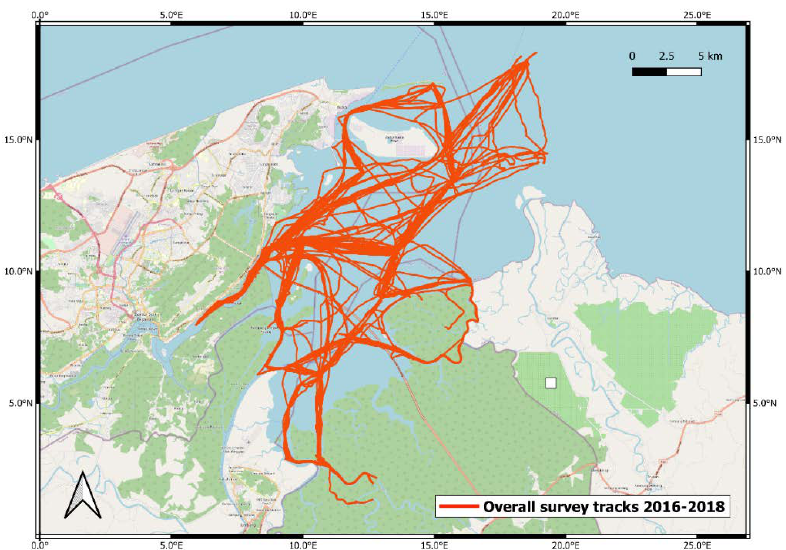
Travelling: swimming, diving and surfacing synchronously. Grouping and moving in the same direction simultaneously.